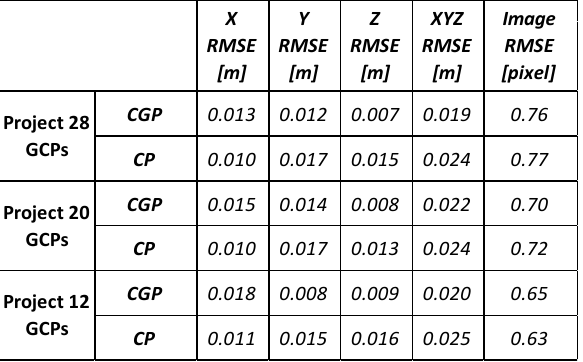
Table 9. Results of RPAS image orientation using a different number of